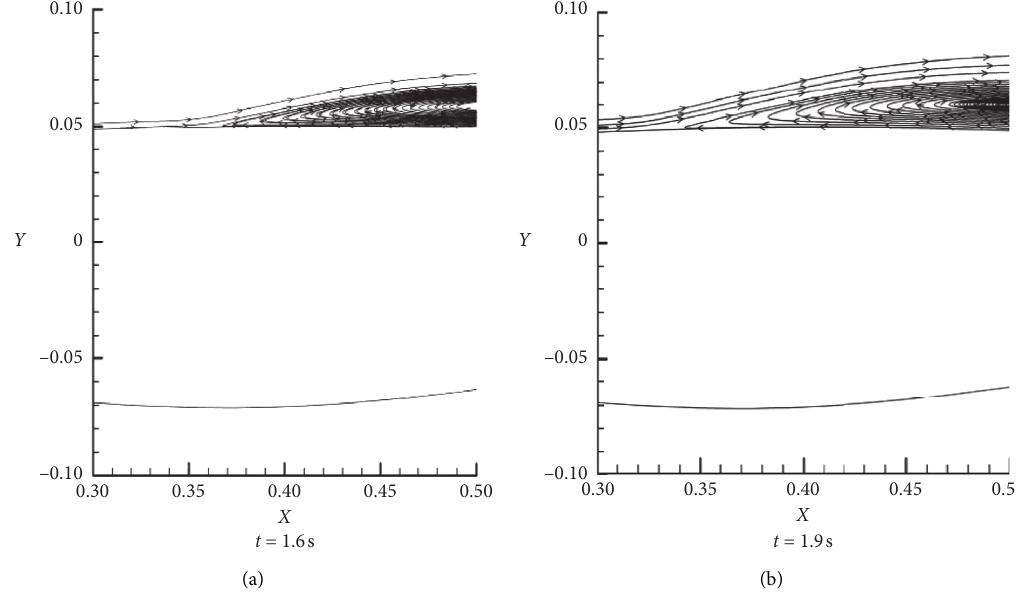
Figure 15: Streamline over leeward flow field of the airfoil at the same camber ( − 3 ° ) in one cycle ( M � 0.74, α � 6 ° , and f � 1Hz, CFD).